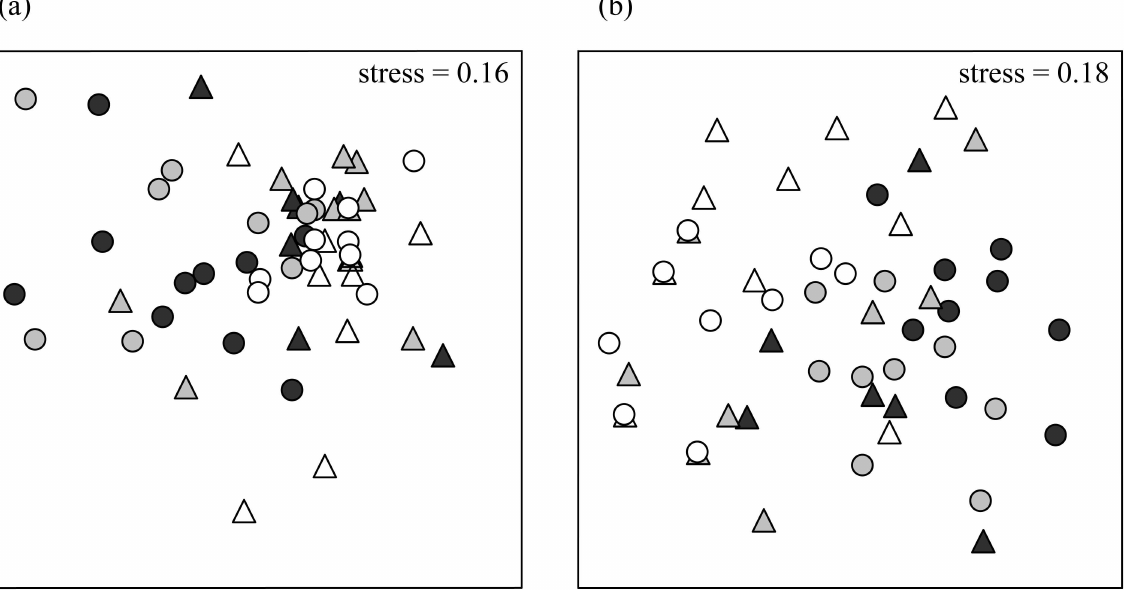
Fig 4. Associations of grazer assemblages with worm-tubes vary according to random sites. nMDS plots of (a) densities,and (b) numbersper boulder, of mobile assemblages (grazers) on boulderswith serpulimorph tubes (triangle)and without (circle). Dark grey symbols are from Site 1, light grey from Site 2, and white from Site 3. Results from PERMANOVA pairwisetests are shownunder the plots; n =